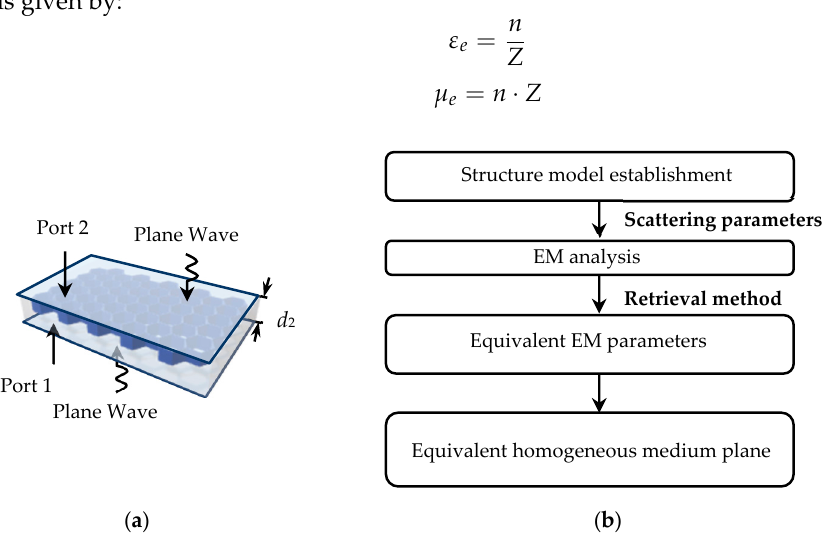
Figure 5. The solution process of the equivalent model, ( a ) the solution physical model, and ( b ) the process of the presented solution method.